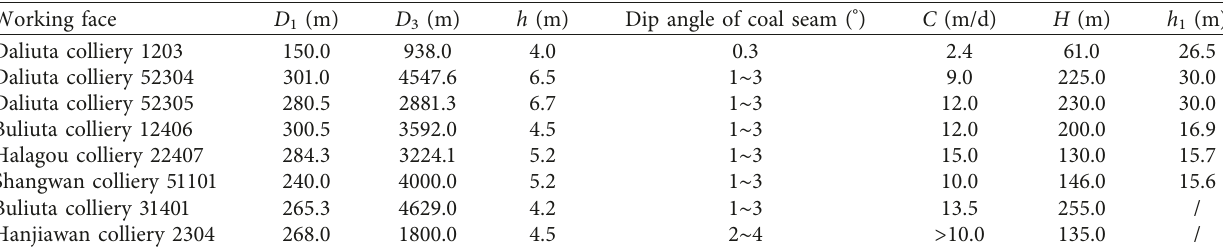
Figure 11: Dynamic extension and distribution of surface crack due to SLWF, (a) advanced 0.52 H ; (b) advanced 0.85 H ; (c) advanced 1.12 H ; (d) advanced 1.37 H ; (e) advanced 2.18 H [19, Table 1: Mining and geological conditions of some SLWF [28–34, 41].